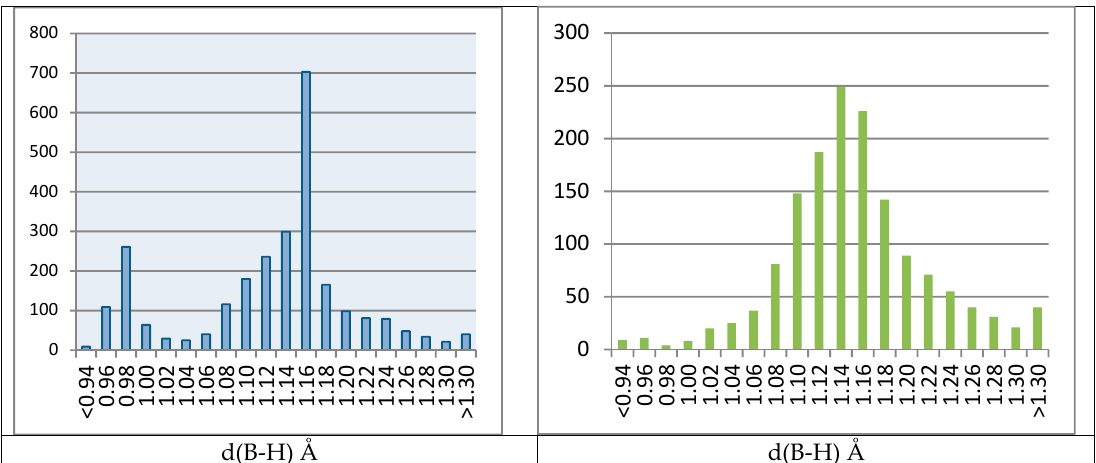
Figure 6. Histograms of bond lengths for all B–H bonds (left) and B–H bonds in probably refined BH 3 groups (right).